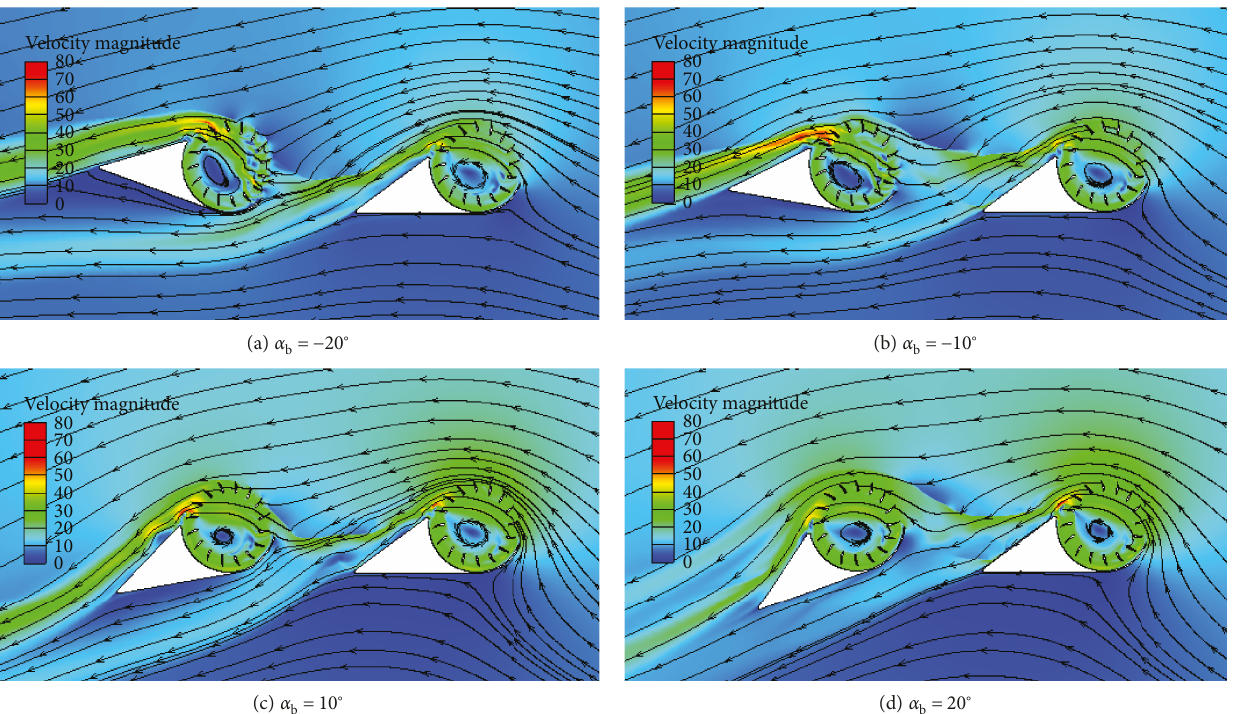
Figure 13: Velocity contours and streamlines of the lift and thrust of the front and rear fan wings when the front wing is fi xed.